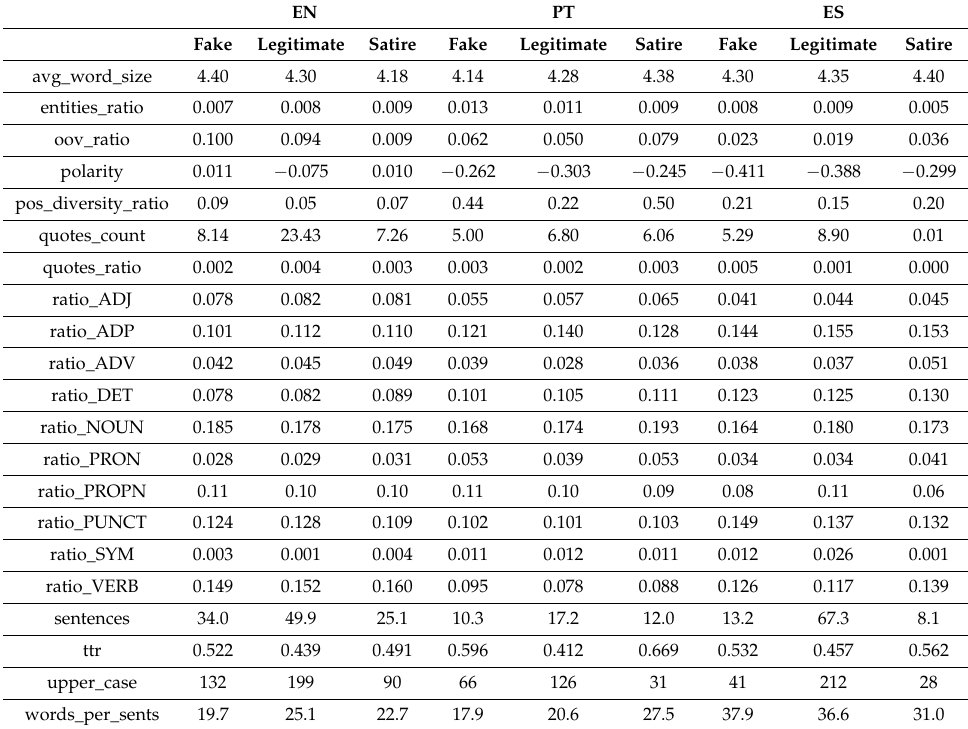
Table 4. Average values of all features grouped by class and by language corpus, in alphabetical order. EN PT ES Fake Legitimate Satire Fake Legitimate Satire Fake Legitimate